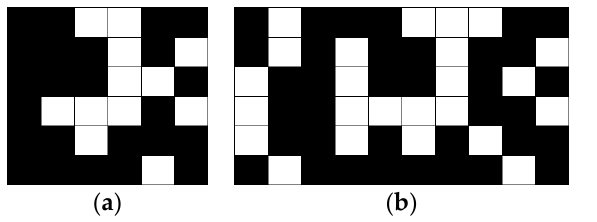
Figure 3. An example of checking coding of ECCs: ( a ) is the XOR code of Figure 2b,c, and ( b ) is the result of Hamming coding of ( a ).